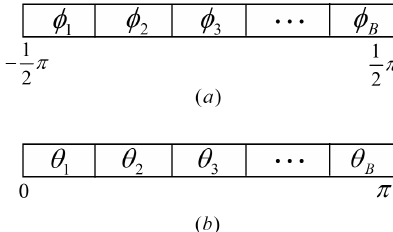
Figure 5. The linearly divided angles according to the B -bits. ( a ) azimuth angles; ( b ) elevation angles.